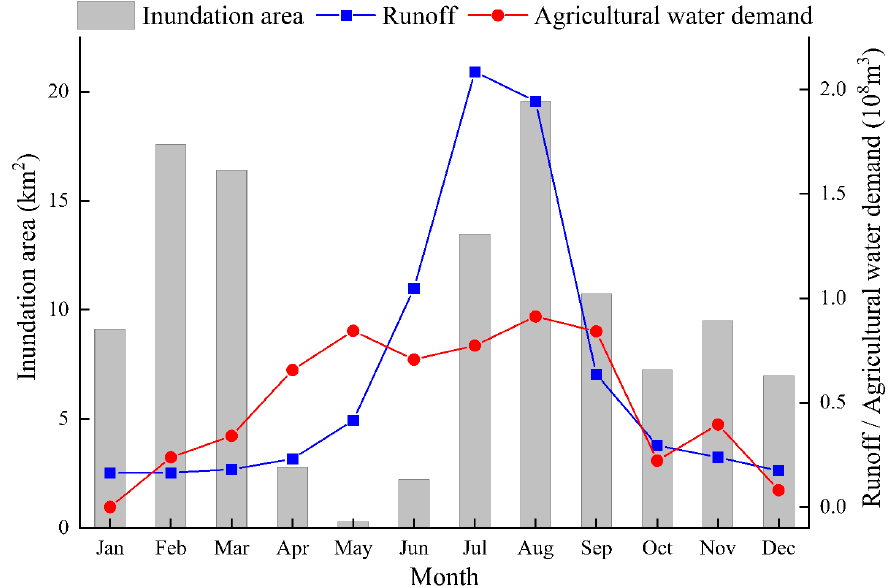
Figure 10. Intra-annual (seasonal) variations in inundation area within the Daliyaboyi Oasis (19-year average between 2000 and 2018), upstream runoff (16-year mean between 2000 and 2015) and the midstream agricultural water demand (in 2009) in the Keriya River catchment.